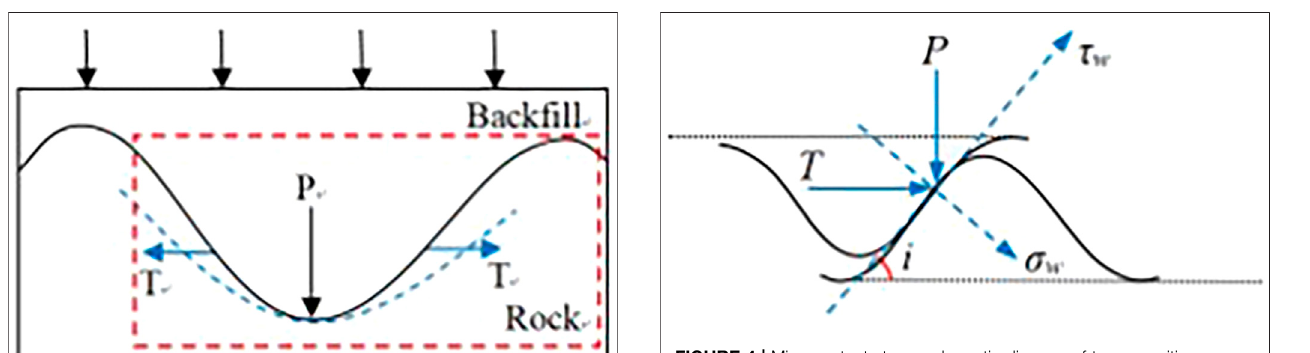
FIGURE 4 | Microcontact stress schematic diagram of two asperities.